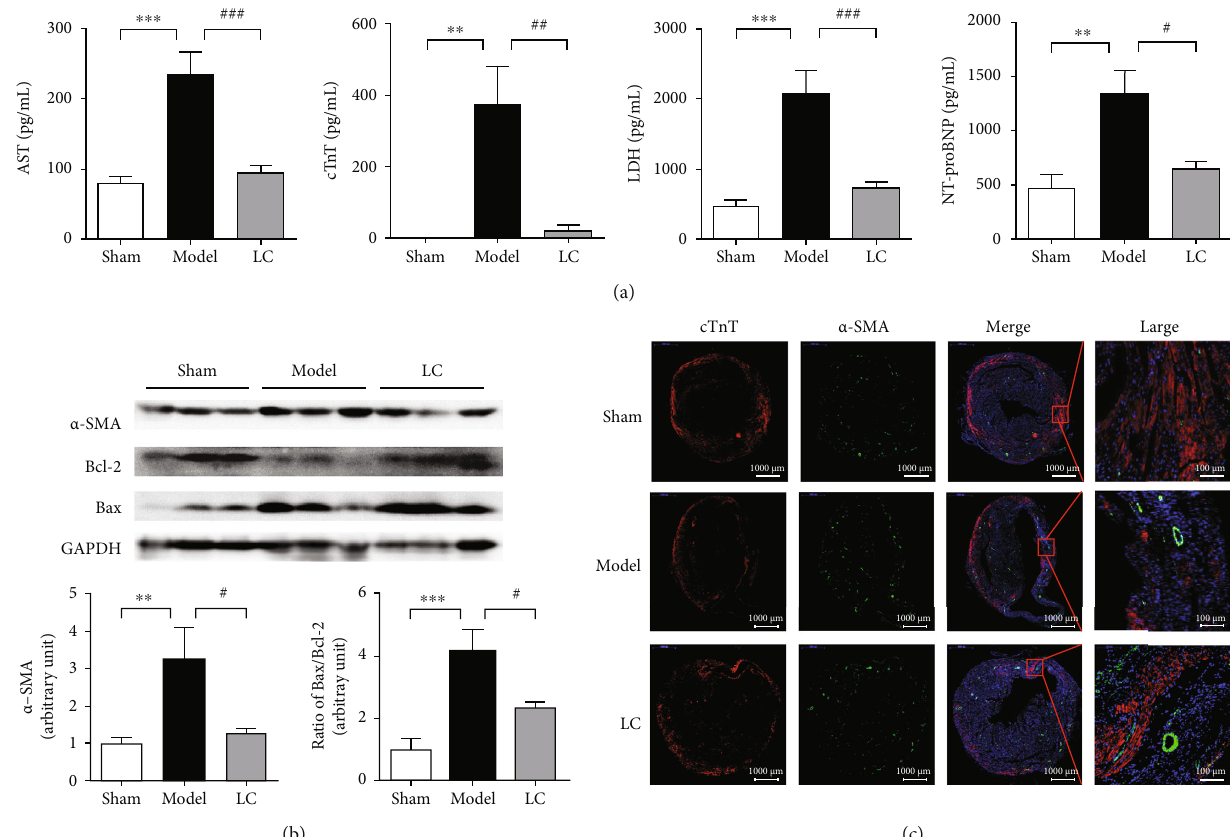
Figure 4: L-carnitine inhibited the Bax/Bcl-2 signal pathway and improved myocardial infarction. (a) Levels of biomarkers for MI were measured after LC treatment. Data were expressed as means ± SEM . n = 8 ; ∗∗ p < 0 : 01 , ∗∗∗ p < 0 : 001 , compared to the sham group. # p < 0 : 05 , ## p < 0 : 01 , and ### p < 0 : 001 , compared to the model group. (b) Representative Western blots of Bax/Bcl-2 and the level of α - SMA in MI mice in the presence or absence of LC treatment. Data were expressed as means ± SEM . n = 6 ; ∗∗ p < 0 : 01 , ∗∗∗ p < 0 : 001 , compared to the sham group. # p < 0 : 05 , compared to the model group. (c) Immuno fl uorescent staining of α -SMA (green) and cTnT (red) were performed, scalebar = 1000 μ m in original images and scalebar = 100 μ m in enlarged